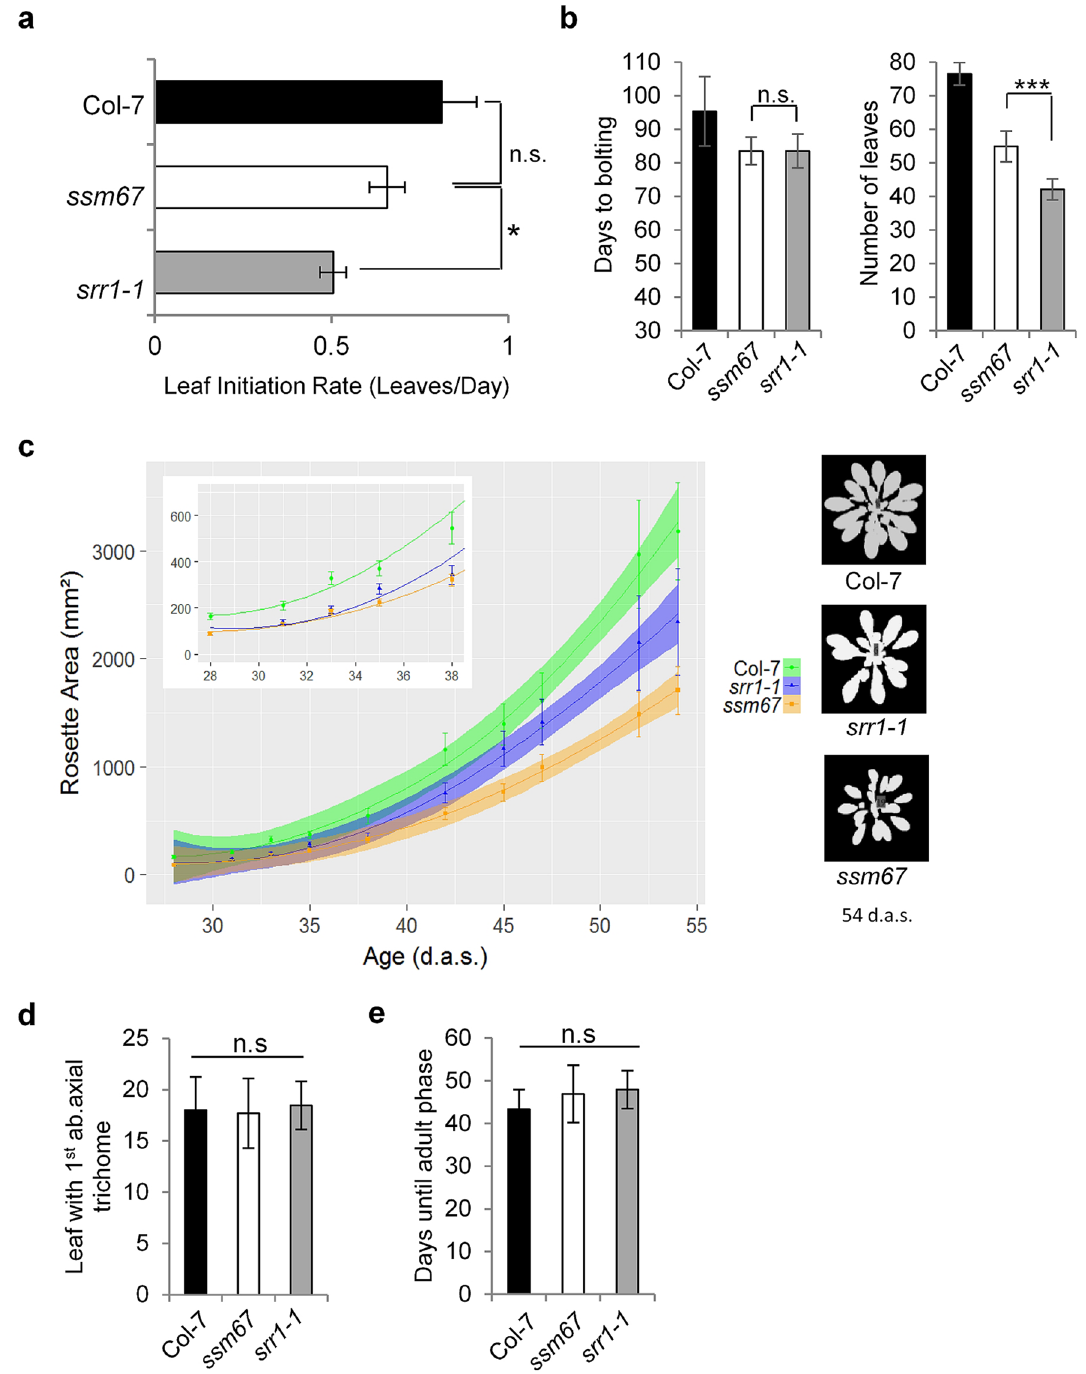
Figure 4. The ssm67 mutation affects plant development. ( a ) Leaf initiation rate of ssm67 compared to Col-7 wt and srr1-1. ( b ) Flowering time of ssm67 compared to Col-7 wt and srr1-1 in SDs, measured in days to bolting (left) and leaves to bolting (right) from n = 15–20 plants. Data are means ± s.d. To determine statistical significance, a Kruskal–Wallis test was performed (* P ≤ 0.05, *** P ≤ 0.001, n.s. not significant). ( c ) Rosette size of ssm67 compared to Col-7 wt and srr1-1 in SDs. ( d , e ) Trichome distribution. Col-7 wt, srr1-1 , and ssm67 mutant plants were grown in SDs at 20 °C. The leaf with the first abaxial trichome ( d ) and the number of days until first abaxial trichome ( e ) were observed (n = 15–20 plants, data are means ± s.d). To determine statistical significance, a Kruskal–Wallis test was performed ( n.s . not